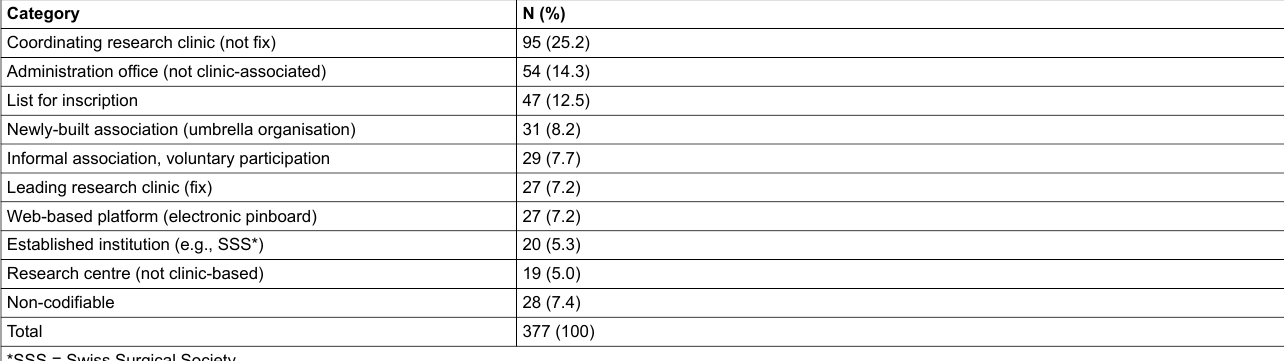
Table 5: Frequency distribution of design proposals (n = 377 responses) for a national research network in surgery given by 266 surgeons; multiple responses were allowed. Category N (%) Coordinating research clinic (not fix) 95